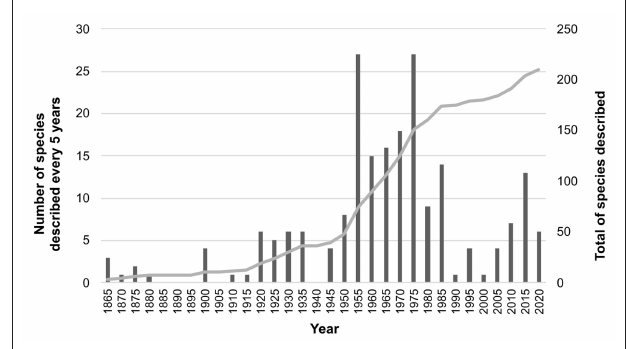
FIGURE 1 | Number of species descriptions of Cyatholaimidae along the years. The bars indicated the number of descriptions every 5 years and the line shows the accumulated